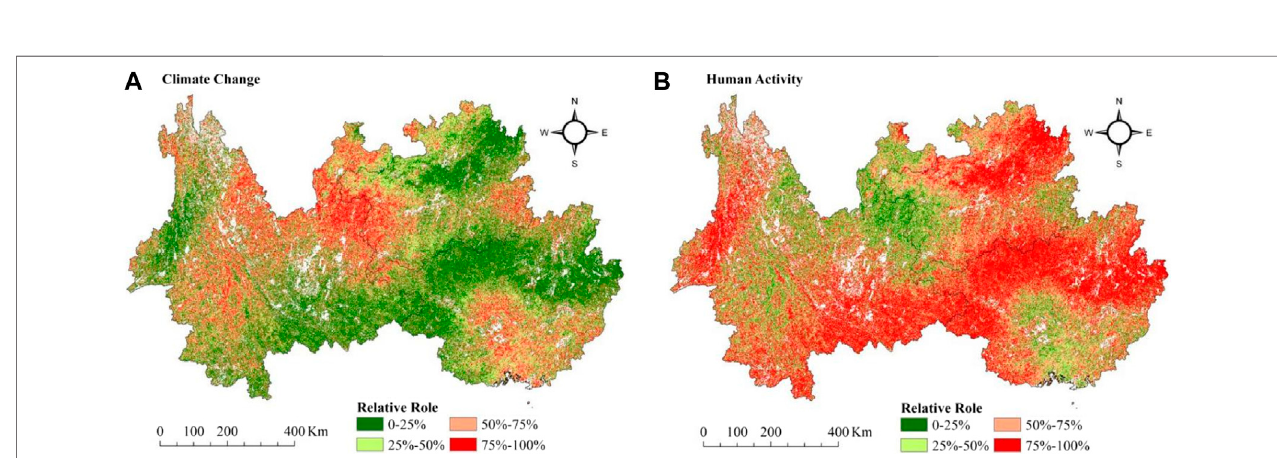
FIGURE 5 | The spatial distribution of NDVI variation trends in the three karst provinces of southwest China from 2001 to 2019.